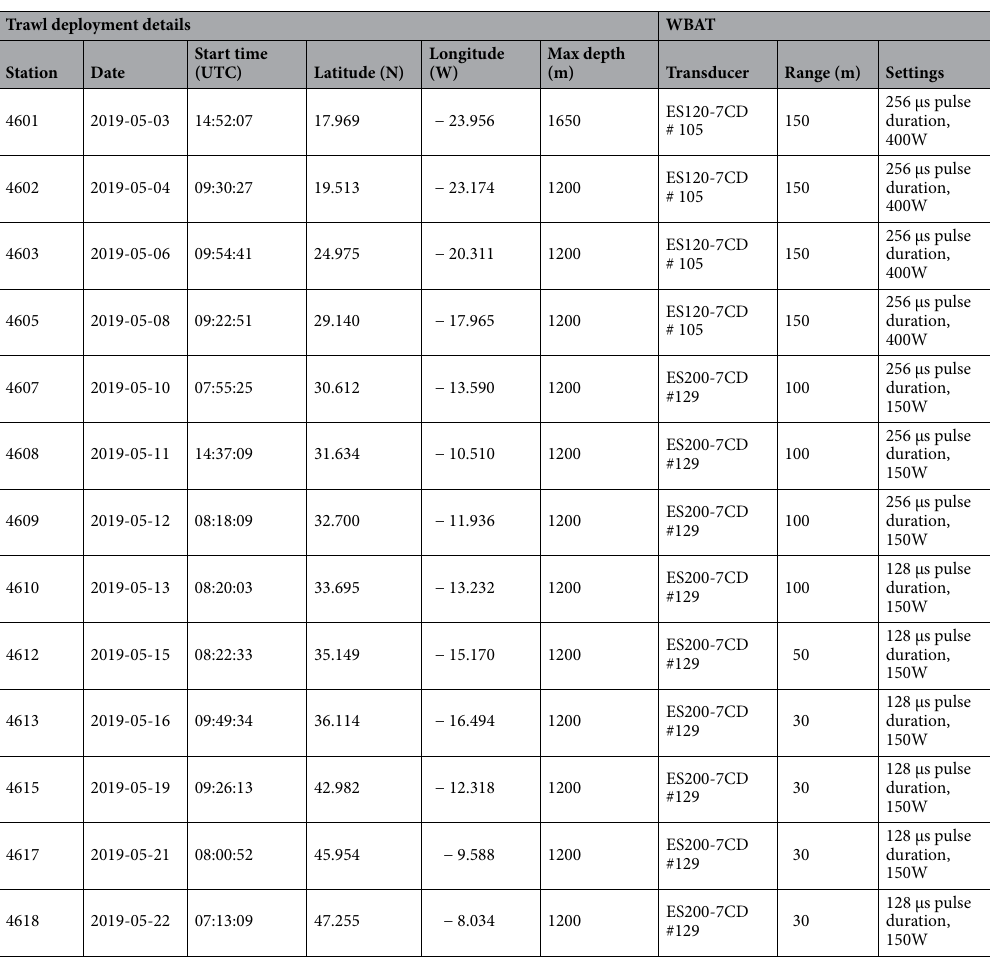
Table 2. Overview of macroplankton trawl deployments on where a WBAT was